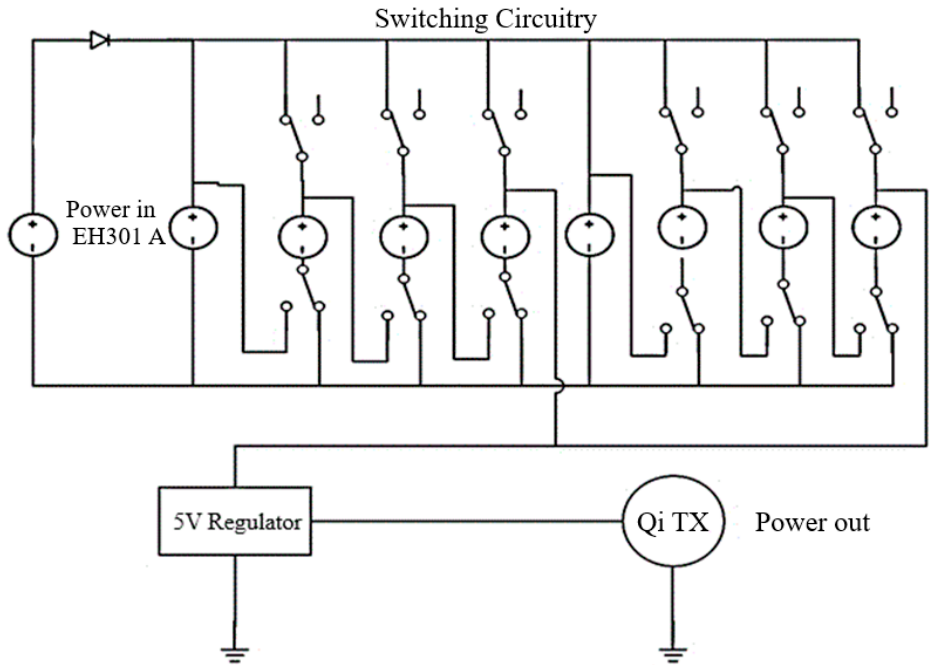
Figure 11. Switching Circuitry of Proposed System.